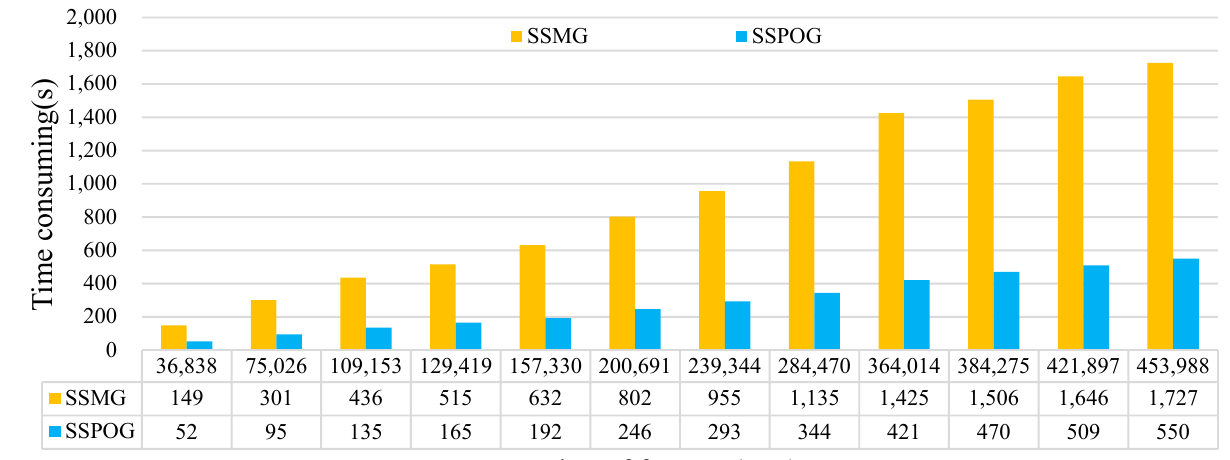
Figure 6. Time required for storage of shapefile data using two methods with different numbers of features.